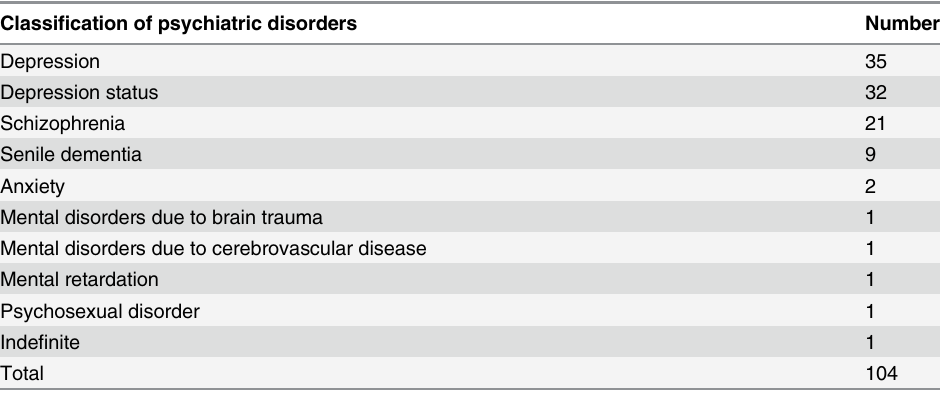
Table 8. Classification of psychiatric